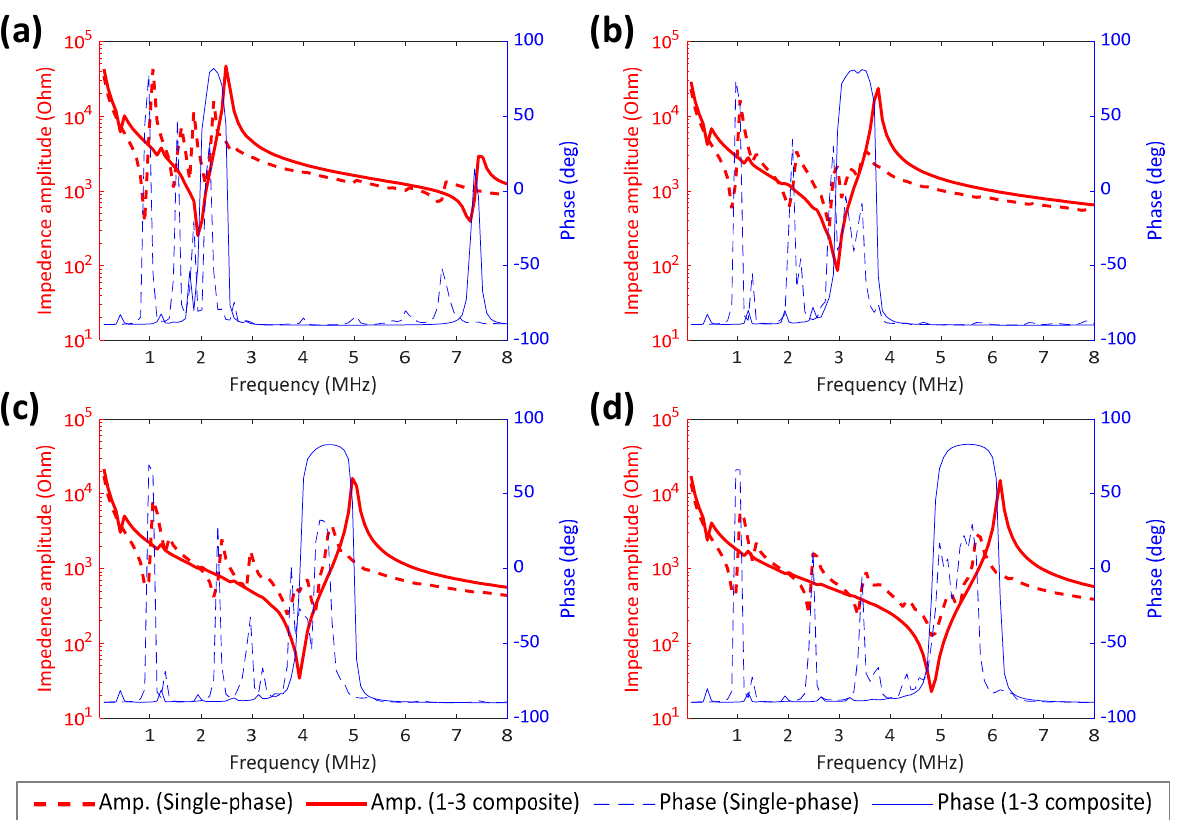
Figure 9. Electric impedance responses of the single- and the 1–3 composite transducers designed for ( a ) 2 MHz, ( b ) 3 MHz, ( c ) 4 MHz, and ( d ) 5 MHz.